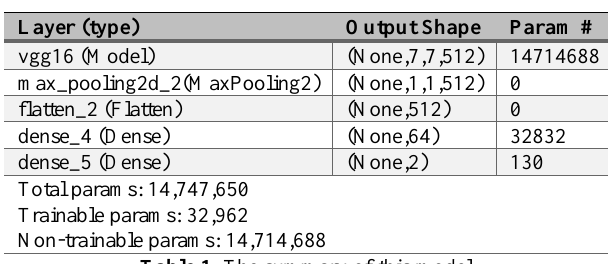
Table 1. The summary of this model.